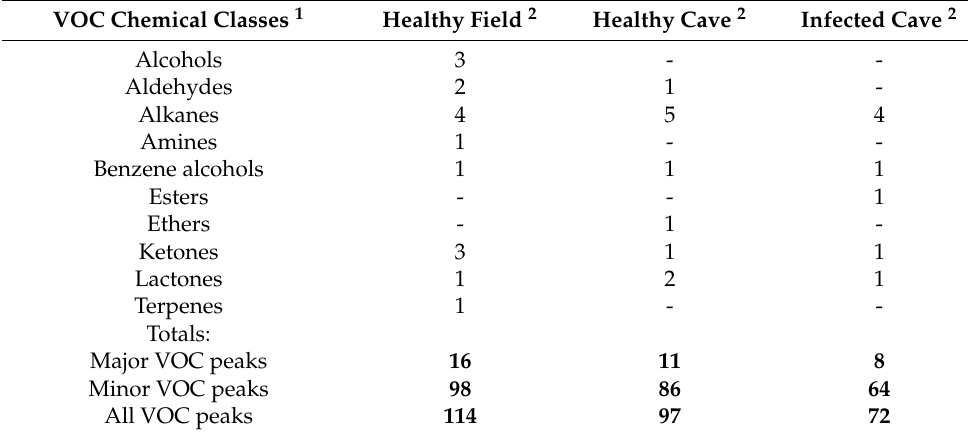
Table 4. Summary of major and minor whole-body VOC emissions from healthy active extracave (field) bats, healthy inactive intracave bats, and WNS-diseased intracave tricolored